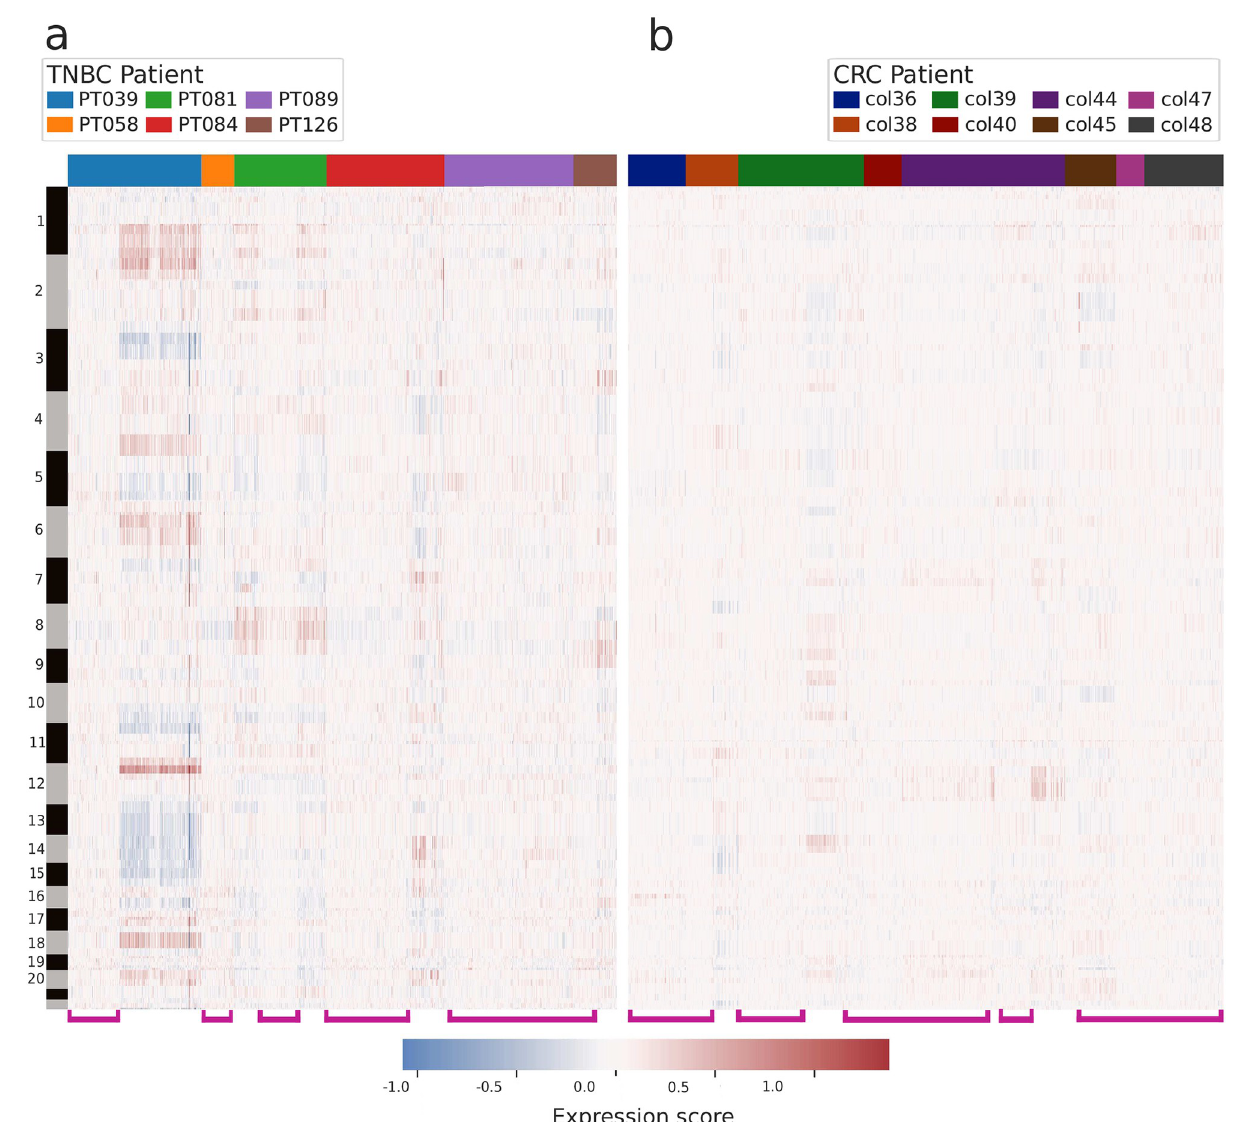
Fig 1. Heatmap visualizing inferred CNV results obtained using CopyKAT [10]. Columns represent individual cells, rows represent genes arranged by chromosomal position. Alternating bars on the y-axis indicate chromosome. Cells are clustered hierarchically within each patient using expression score matrices. Pink brackets indicate cells with low inferred CNV. Panel (A) shows results for the TNBC dataset and panel (B) for the CRC dataset.